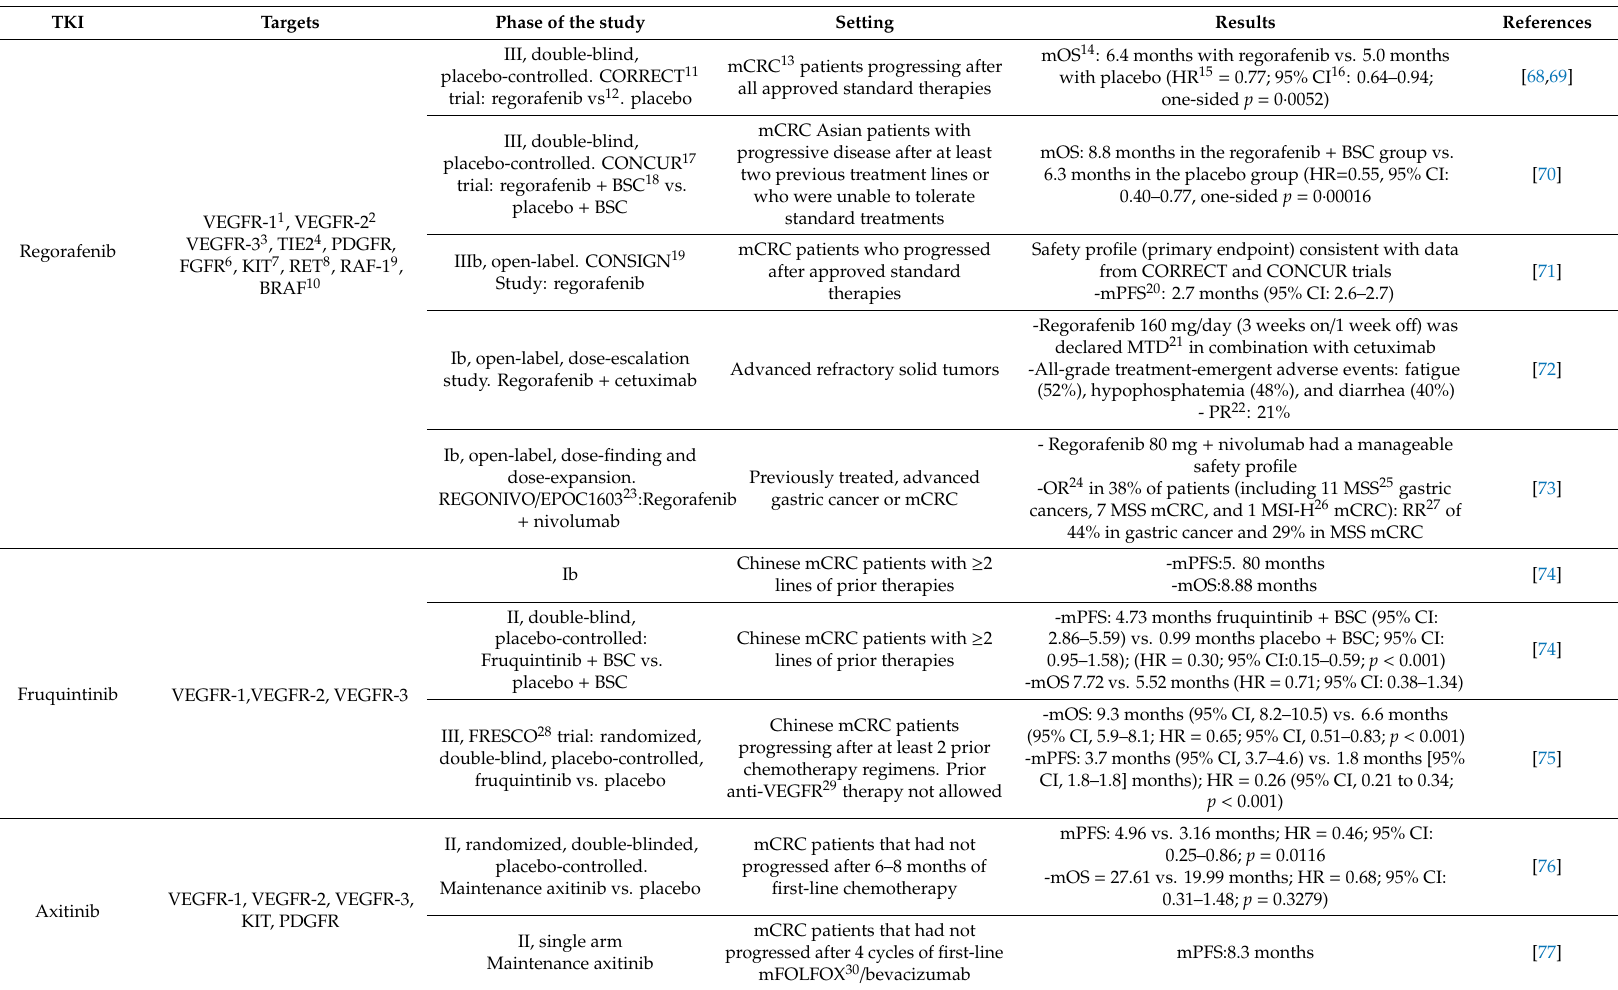
Table 4. Tyrosine kinase inhibitors (TKIs) for pretreated metastatic colorectal cancer treatment. TKI Targets Phase of the study Setting